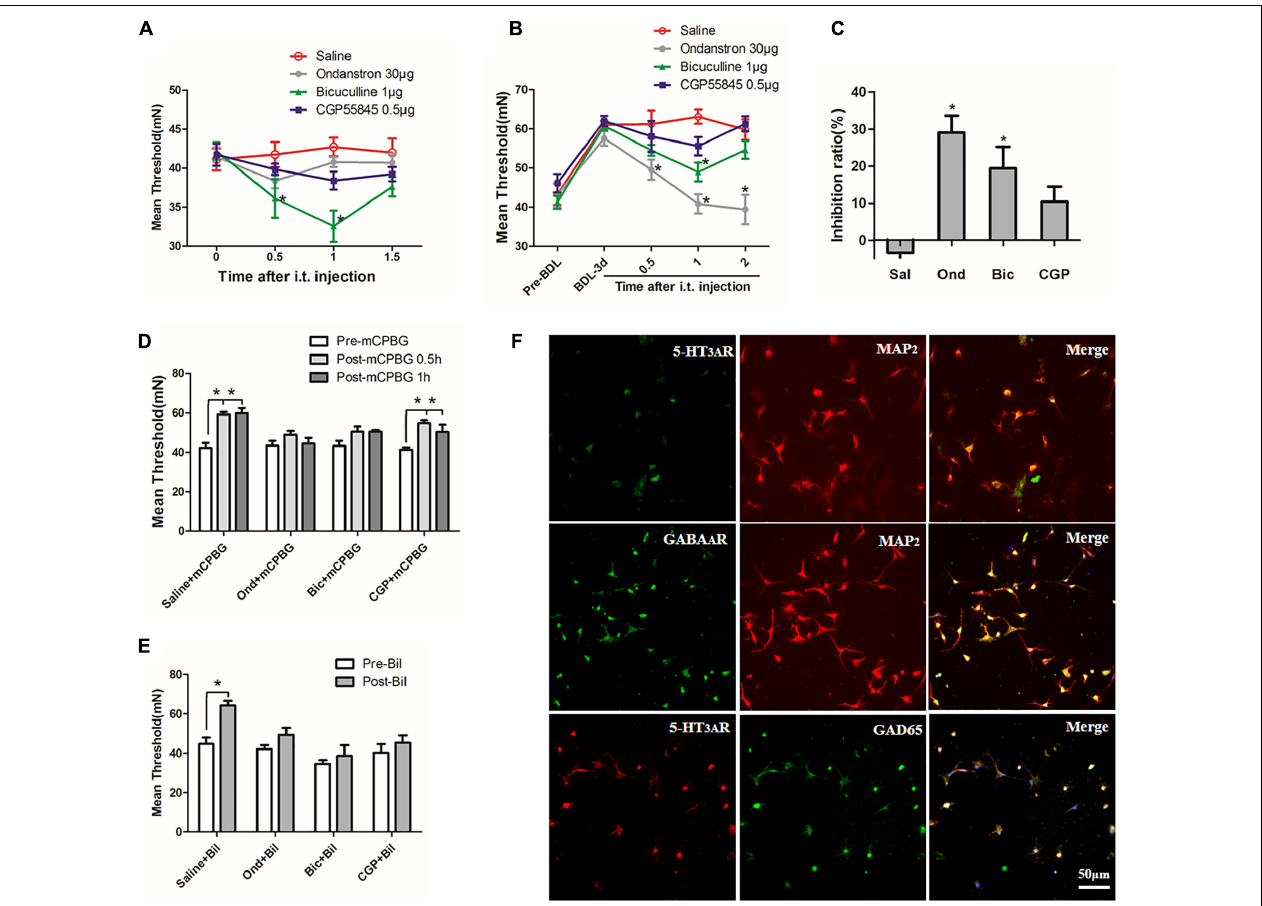
FIGURE 5 | The 5-HT 3 A receptor regulated pain thresholds through GABA pathway in cholestasis rats. (A) In normal rats, bicuculline reduced mechanical threshold significantly by intrathecal injection 30 min later. (B) In BDL rats, both ondansetron and bicuculline reversed the increased pain thresholds. (C) Comparison of inhibition ratios among three antagonists. Results showed that ondansetron exerted stronger inhibition ratio than bicuculline and CGP55845 in BDL rats. (D) Both ondansetron and bicuculline, but not CGP55845, could reverse the up-regulation of pain threshold induced by mCPBG in normal rats. (E) Ondansetron, bicuculline, and CGP55845 could reverse the effect induced by intrathecally administrating bilirubin in normal rats. (F) Expression of the 5-HT 3 A receptor on GABAergic neurons in cultured SDHNs. Most of the cultured neurons (MAP2 is regarded as neuron marker) expressed the 5-HT 3 A receptor and GAD65 (marker of GABAergic neuron). The merged images showed co-expression of the 5-HT 3 A receptor and GAD65, suggesting that the majority of GABAergic neurons expressed the 5-HT 3 A receptor in SDH. * P <